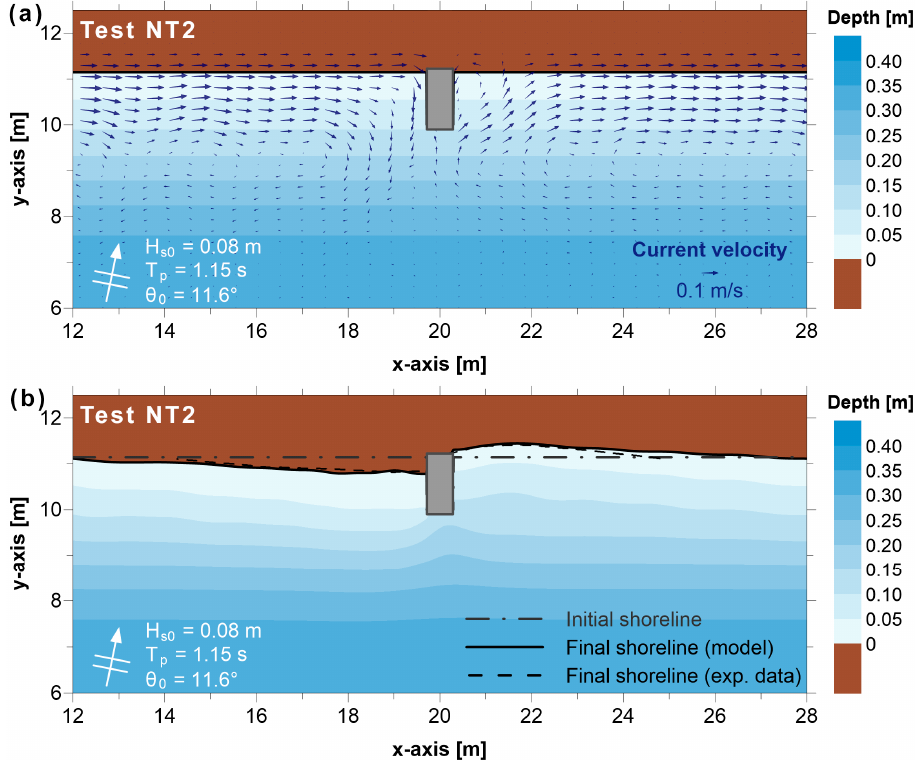
Figure 4. ( a ) Initial breaking wave-induced current velocity field (contours represent the initial bathymetry) and ( b ) comparison between the computed and measured shoreline evolution (contours represent the final computed bathymetry) for Test NT2 of Baidei et al. [22].